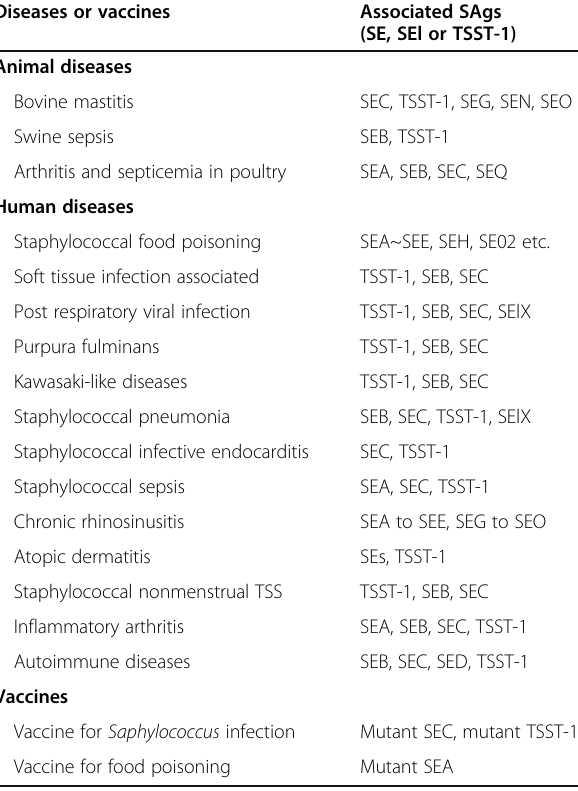
(SE, SEl or TSST-1)